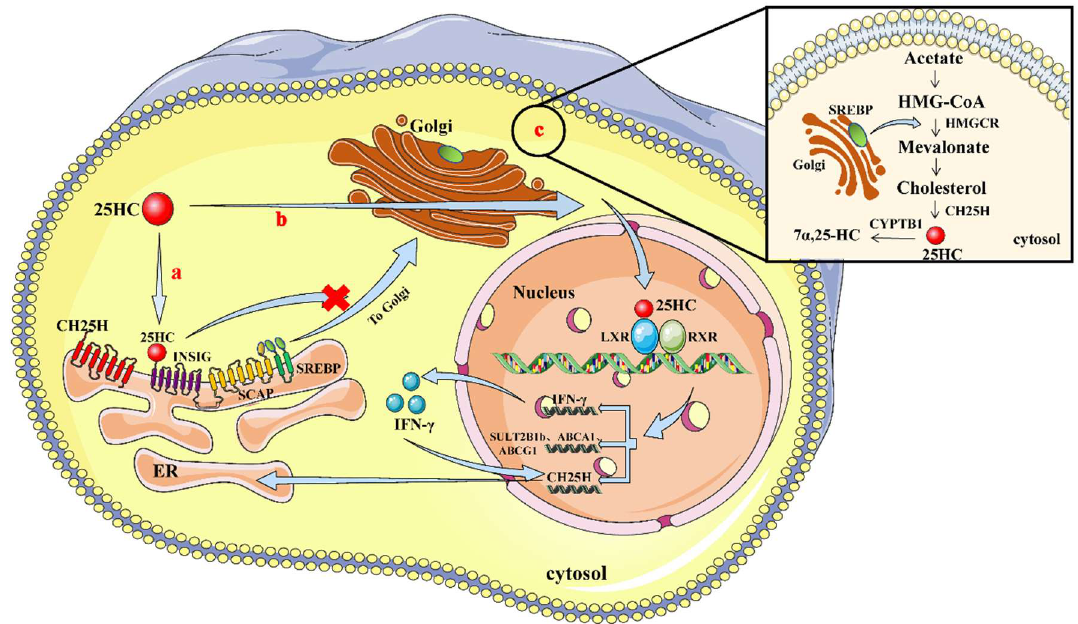
Figure 1. Patterns illustrating how CH25H and 25HC are involved in cholesterol metabolism. a, Regulation of sterol regulatory element-binding proteins (SREBP) by 25HC. 25HC binds to insulin-induced gene 2 (INSIG2) proteins and forms SREBP / INSIG22 / cleavage activator protein (SCAP) complexes that are retained on the endoplasmic reticulum (ER) and therefore block the transportation of SREBP-SCAP complexes to the Golgi apparatus. b, As the ligand of liver X receptor (LXR), 25HC can enter the nucleus to induce the expression of cholesterol-25-hydroxylase (CH25H), cholesterol sulfotransferase-2B1b (SULT2B1b), ATP-binding cassette transporter A1 (ABCA1), ATP-binding cassette transporter G1 (ABCG1), and interferon gamma (IFN- γ ), and activated IFN- γ can enhance the expression of CH25H via feedback regulation. c, SREBP promotes the expression of 3-hydroxy-3-methylglutaryl-CoA reductase (HMGCR) and subsequent cholesterol synthesis, while CH25H enzyme converts cholesterol to 25HC. 25HC 7 α -hydroxylase (CYP7B1)-mediated hydroxylation contributes to converting 25HC to 7 α ,25-dihydroxycholesterol (7 α ,25HC). RXR, retinoid X